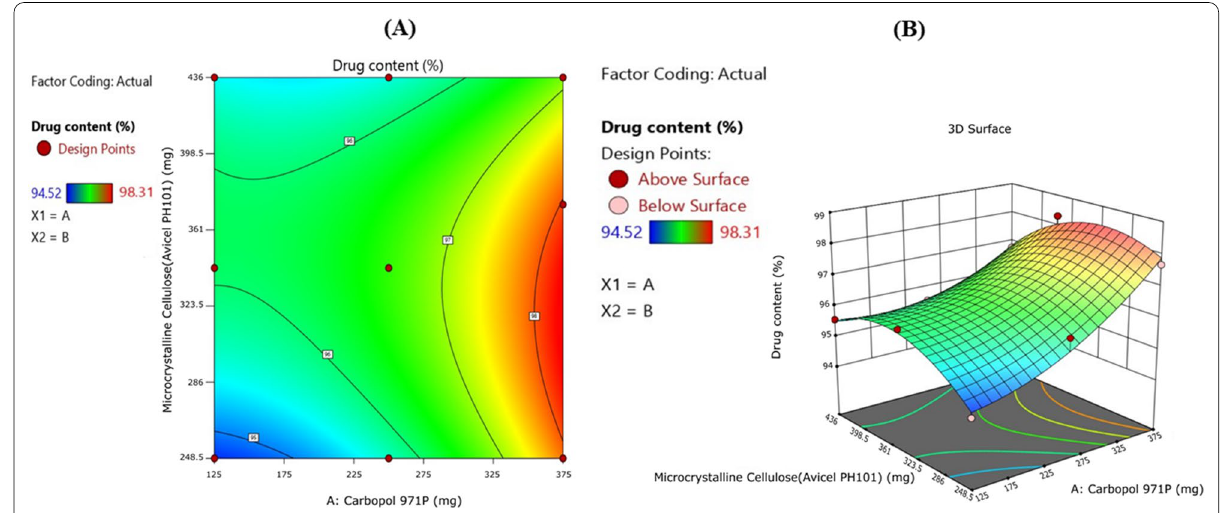
Fig. 1 A Contour plot, and B Response surface plot for dependent variables of MFH-SR pellets with drug content as a